Question: Write the caption for this figure.
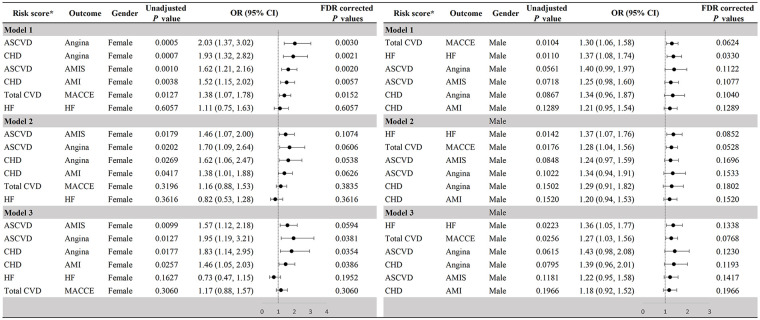
Answer: Association of PREVENT equations with major adverse cardiac and cerebral events. *Risk scores were Z-transformed. Model 1: unadjusted. Model 2 for females: adjusted for ASA classification, arrhythmia, aspirin, current-drink; Model 2 for males: adjusted for atrial arrhythmia, aspirin, current-drink; Model 3 for females: adjusted for ASA classification, arrhythmia, aspirin, current-drink, hemoglobin, neutrophil (%), C-reactive protein (CRP), PT, glucose, and NT-proBNP; Model 3 for males: adjusted for atrial arrhythmia, aspirin, current-drink, hemoglobin, CRP, and triglyceride. AMI, angina and myocardial injury; AMIS, angina, myocardial injury and stroke; ASCVD, atherosclerotic cardiovascular disease; CHD, coronary heart disease; CVD, cardiovascular disease; HF, heart failure; MACCE, major adverse cardiac and cerebral events, including angina, myocardial injury, stroke, or heart failure.